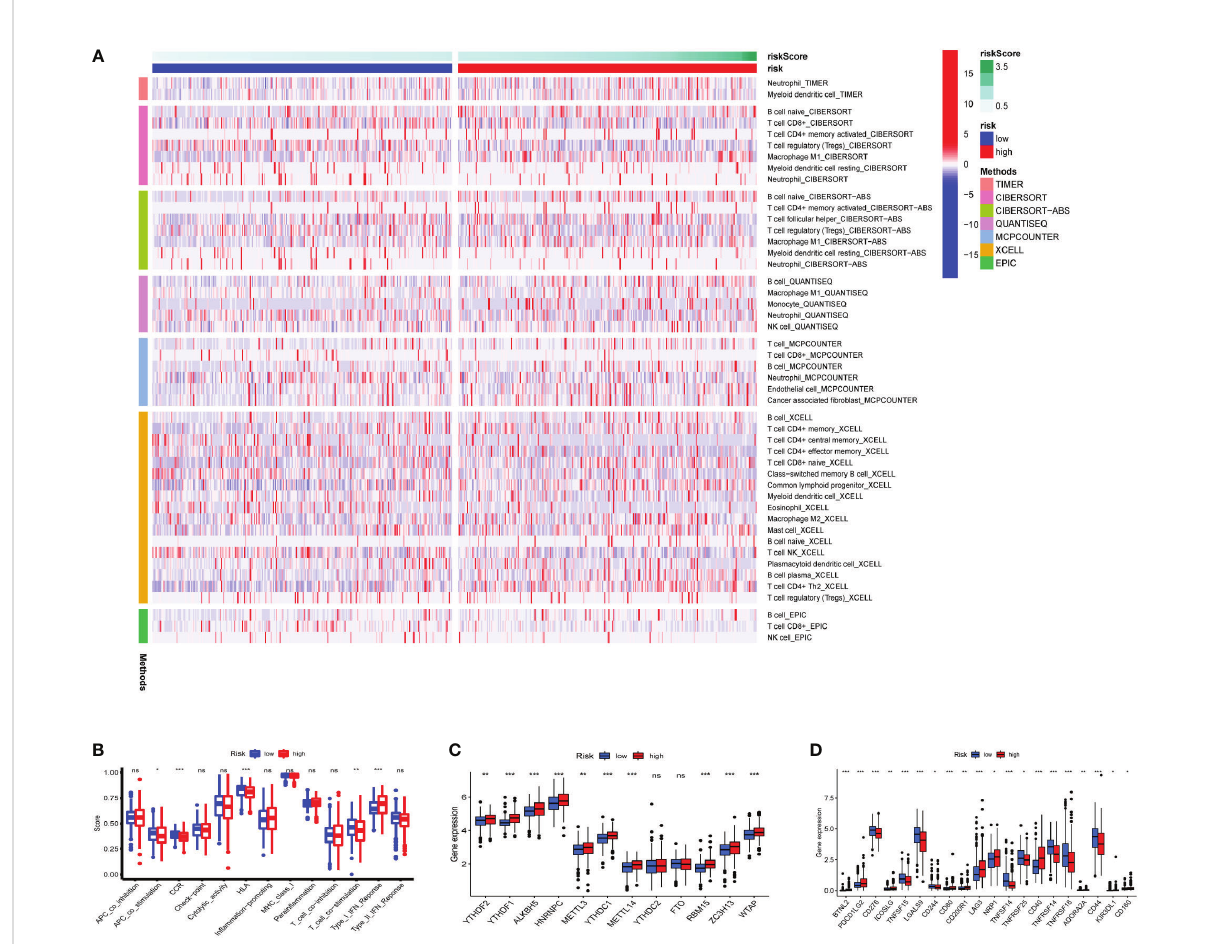
FIGURE 7 Heatmap for immune cells and their related functions, m6A-related genes, immune checkpoints (A) Heatmap for immune cells based on TIMER, CIBERSORT, CIBERSORT − ABS, QUANTISEQ, MCPCOUNTER, XCELL, and EPIC algorithms between two risk groups. (B) The immune cells related functions (C) m6A-related genes (D) immune checkpoints. ns represents a p value >0.05, * represents a p value < 0.05, ** represents a p value < 0.01, and *** represents a p value <